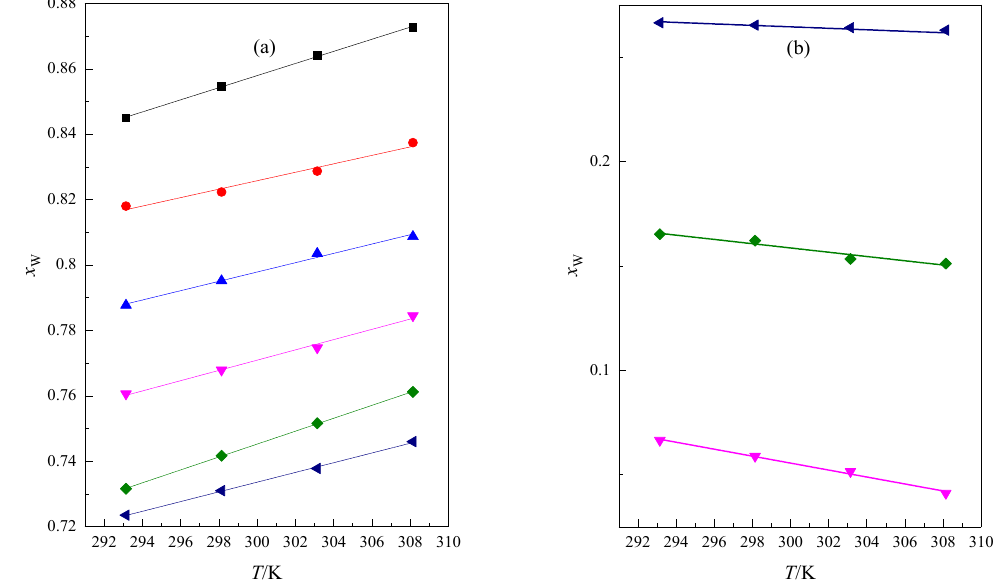
Figure 6. Composition of the solvent ( x W ) corresponding to the first ( a ) and second ( b ) intersection points of the isomolal curves κ S = f ( x W ) as a function of temperature for the examined glymes in the DMF + W mixed solvent: ■ monoglyme [22], ● diglyme [22], ▲ triglyme [22], ▼ tetraglyme [22], ◆ pentaglyme, ◀ hexaglyme.